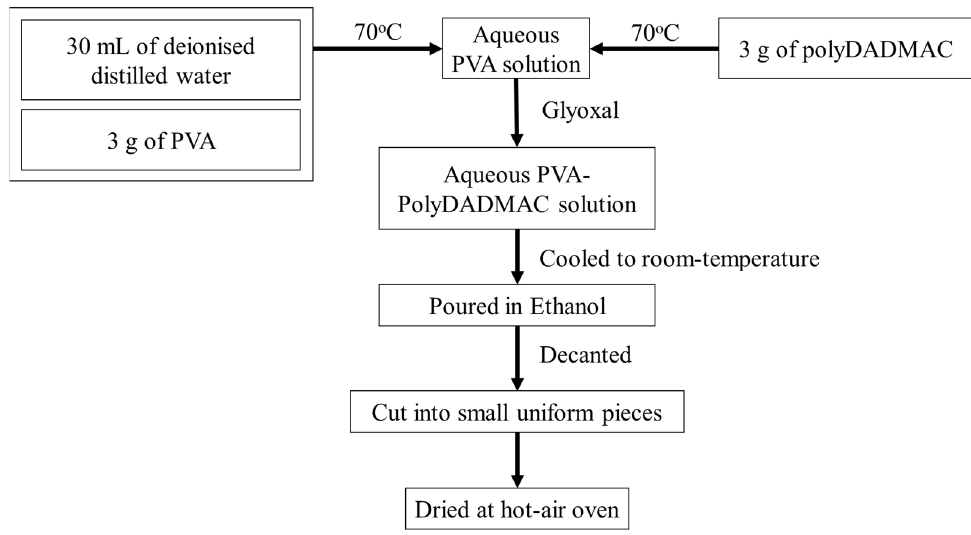
Figure 1. Schematic representation of the method of hydrogel synthesis .